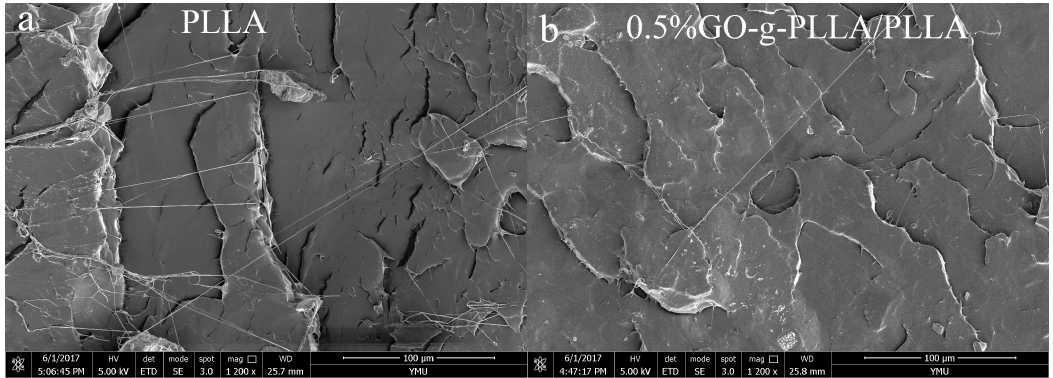
Figure 11. Scanning electron microscopy (SEM) of the tensile fracture surfaces of PLLA and GO- g -PLLA/PLLA.